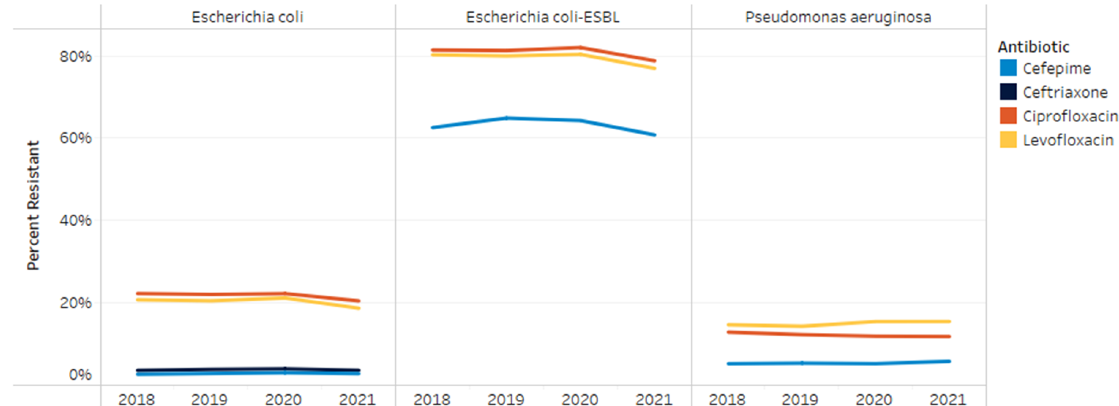
Figure 3. Resistance trends by organism from 2018-2021.